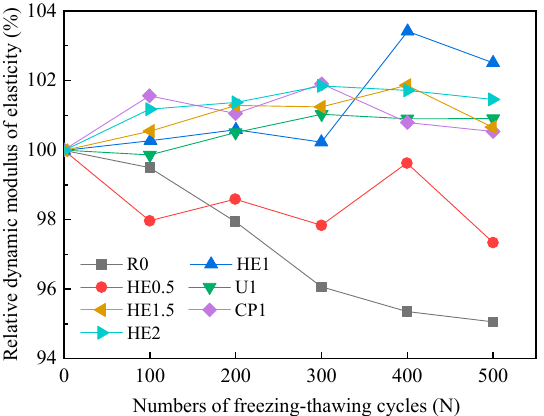
Figure 9. Relative dynamic modulus of elasticity (RDME) of CGAC with different types and content of steel fiber.